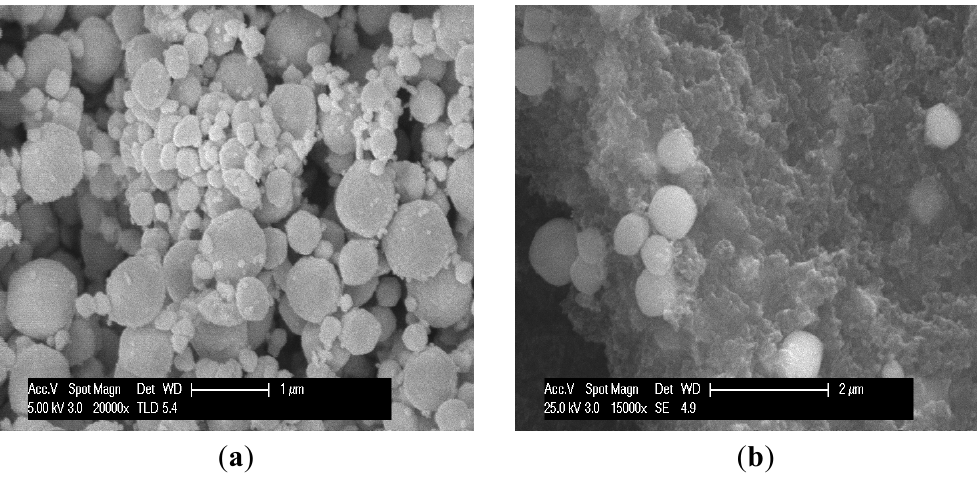
Figure 2. Morphology of the promoter compound; ( a ) alone; ( b ) dispersed in the catalytic layer.